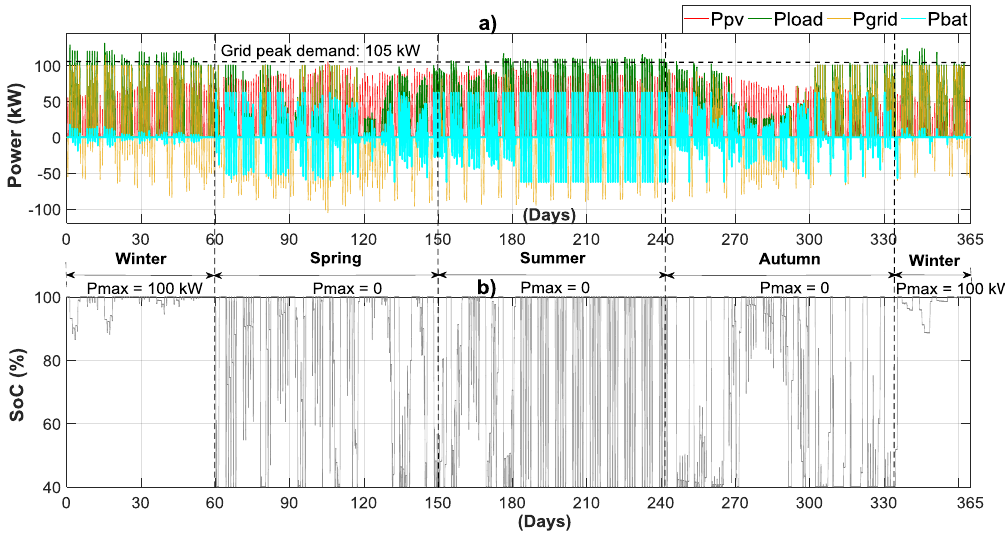
Figure 10. ( a ) Electricity flows in office building with BESS during a year (Case 3); and ( b ) Battery State of Charge (SoC).